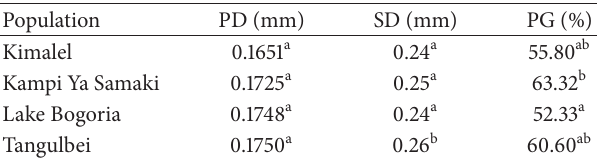
Table 5: Mean pollen germination percentage for the four popula- tions of S. senegal within Lake Baringo woodland ecosystem.